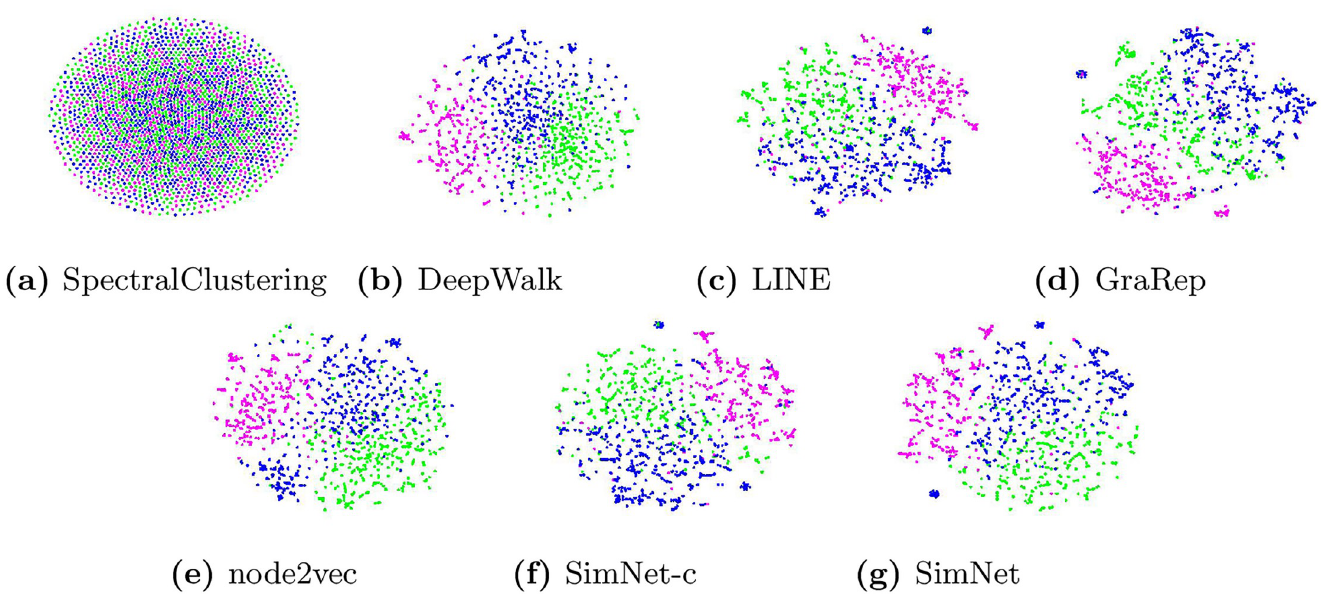
Fig 2. Visualization of author citation network. Each point indicates one author. Green: Data Mining , magenta: Computer Vision and blue: Machine Learning .